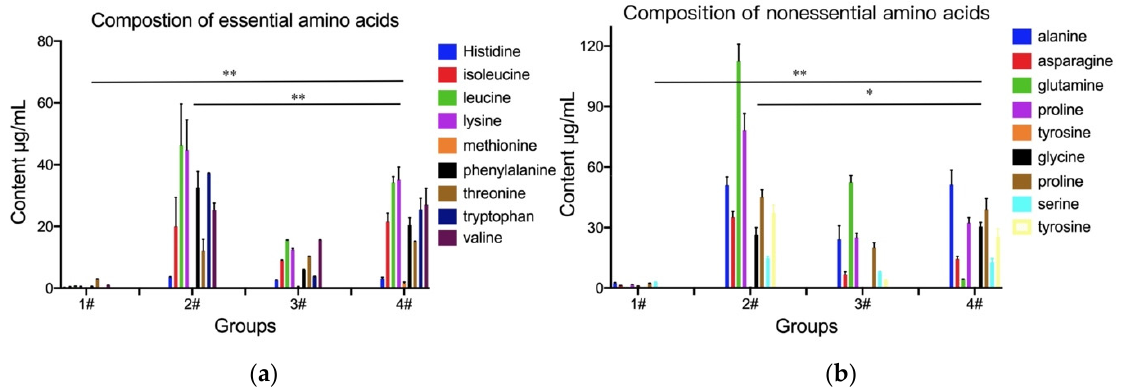
Figure 1. Compositions of essential ( a ) and nonessential amino acids ( b ) in the four treatment groups. **, p < 0.01, *, p < 0.05. **, p < 0.01, *, p <